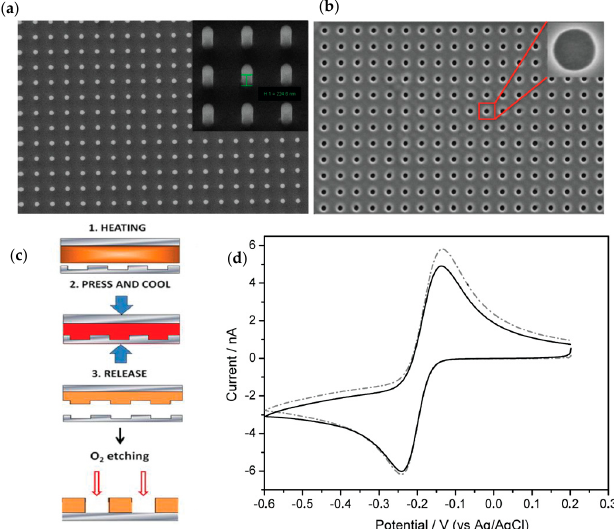
Figure 2. ( a ) SEM images of the stamp obtained for thermal nanoimprint lithography (TNIL) in front view and the inset in tilted view. Array of pillars have average diameter of 250 nm and interspacing distance of 800 nm and ( b ) SEM image of the NEA with dots spaced at the distance of 800 nm, an average diameter of ~260 nm and a depth of ~225 nm plus the magnification of one boron-doped diamond (BDD) nanoelectrode. ( c ) Schematic representation of the thermal nanoimprinting process. ( d ) Cyclic voltammograms of the bare NEA recorded in 0.1 mM MB in 0.01 M PBS at pH 7.2 (black line) with 50 µ M of H 2 O 2 (dashed line). Scan rate, 50 mV s − 1